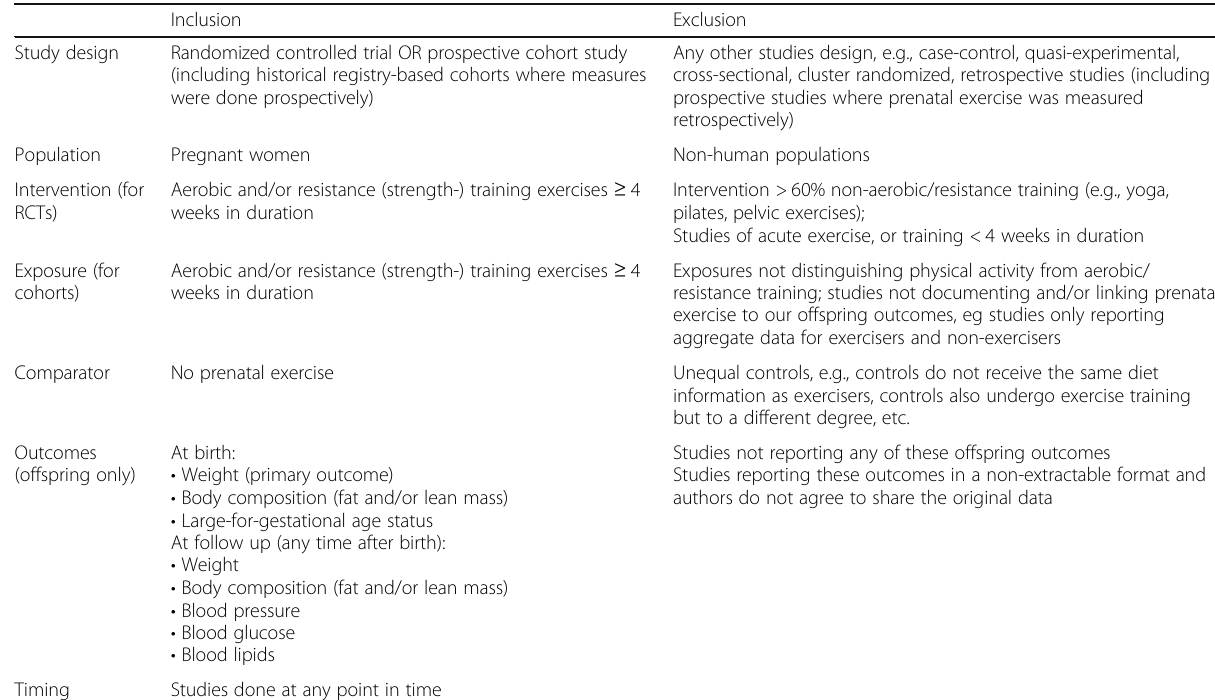
Table 1 Inclusion/exclusion criteria